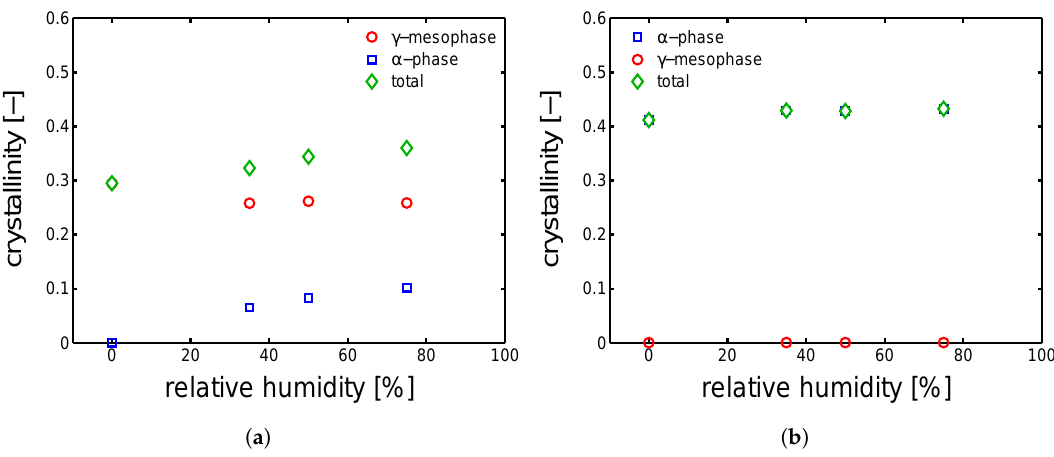
Figure 14. Evolution of the crystallographic phase contents as function of relative humidity (conditioning performed at 23 °C) starting from ( a ) γ -I and ( b ) α -I sample.